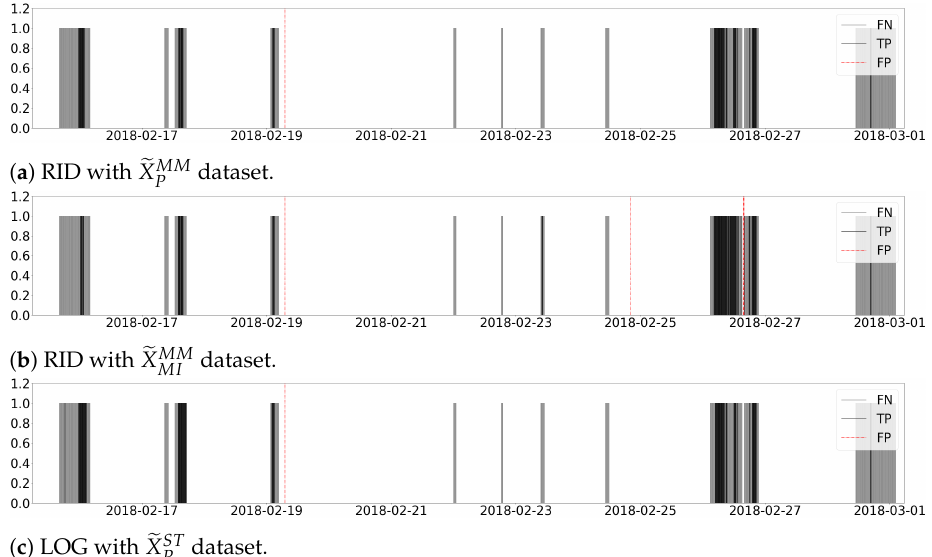
Figure 12. Classification results of the selected